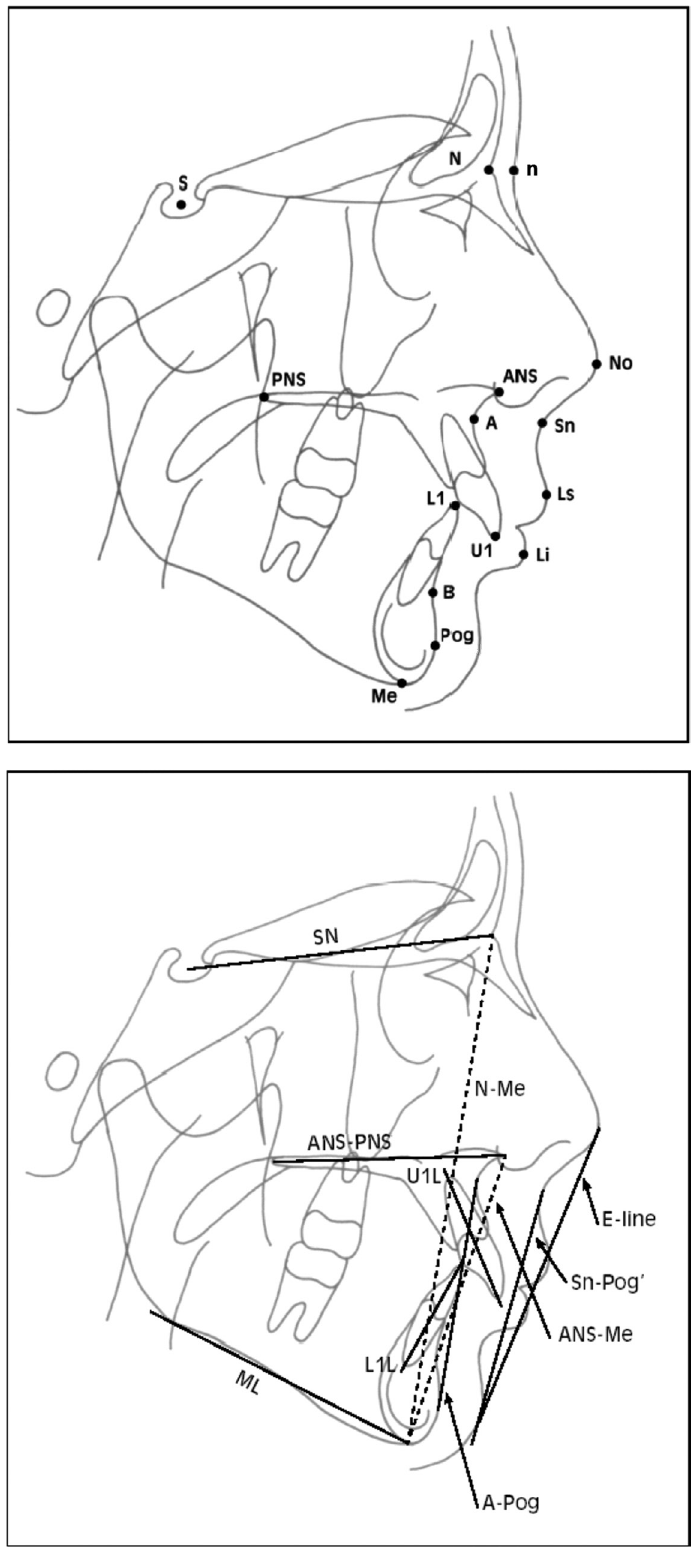
Figure 1. Reference lines and cephalometric points used in this study: A = A-point; ANS = Anterior nasal spine; B = B – point; L1 = Lower incisor edge tip; Li = Lower lip; Ls = Upper lip: Me = Menton; N = Nasion; n = Soft tissue nasion; No = Pronasale; PNS = Posterior nasal spine; Pog = Pogonion; S = Sella; Sn = Subnasale; U1 = Upper incisor edge tip (figure adapted from Stalpers et al. 8